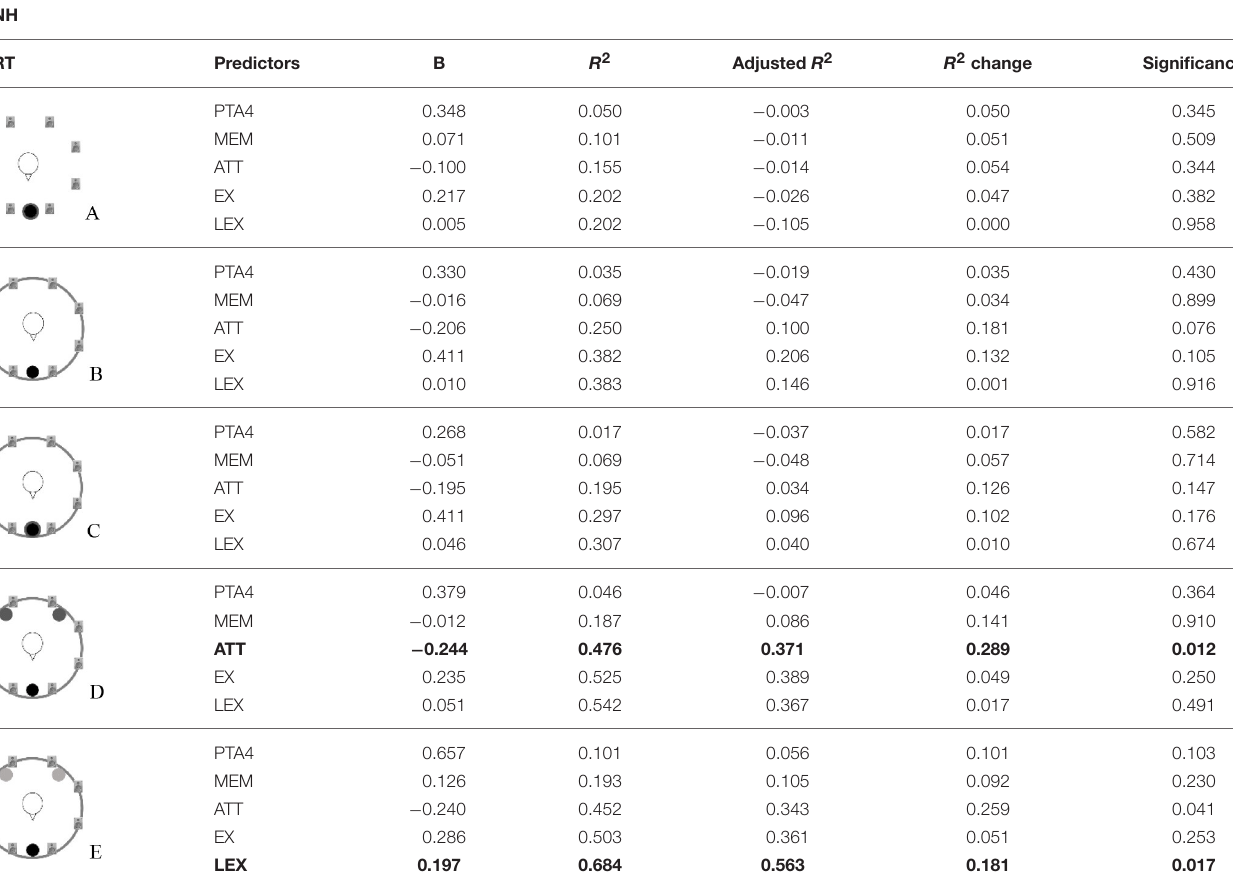
Significant results are highlighted with bold